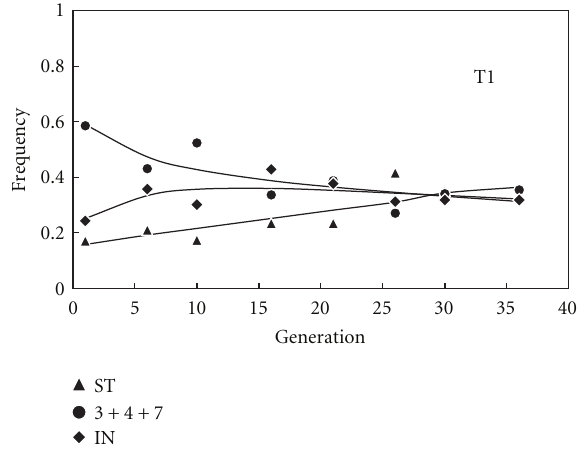
F 1: Observed frequencies (symbols) of arrangements of the chromosome along generations of experimental population T1 of Drosophila subobscura [33] and predicted trajectories (lines) using ML estimates of frequency-, sex-, and stage-independent adaptive 𝑂𝑂 values and initial frequencies from the observed